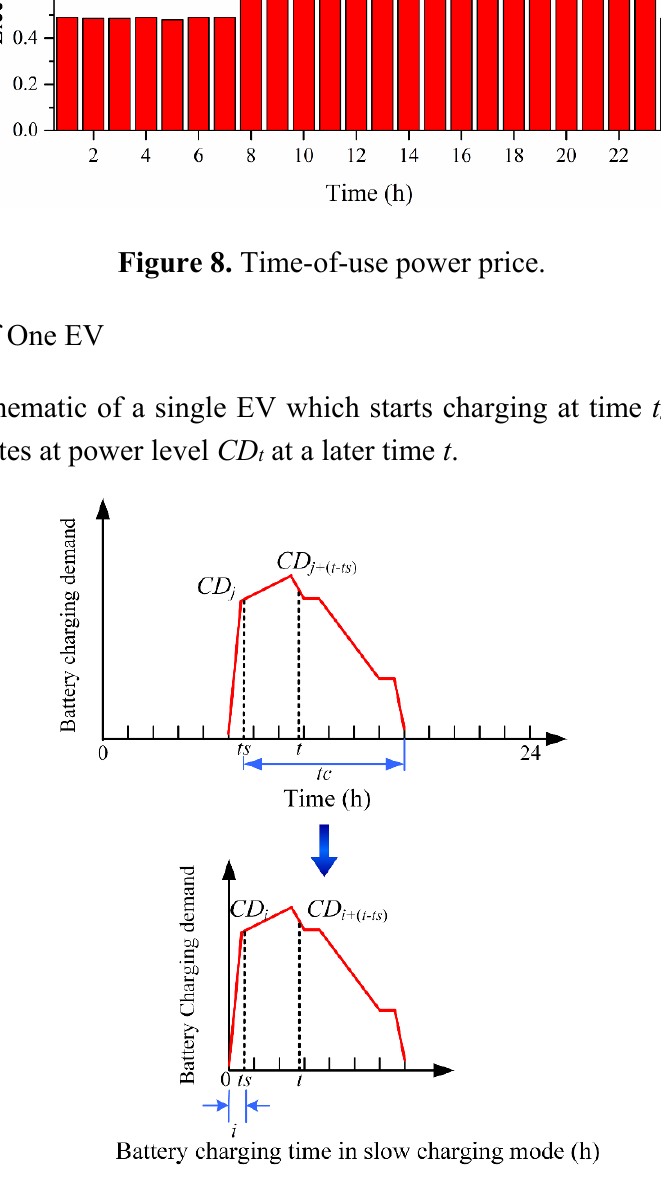
Figure 9. Schematic of charging a single EV